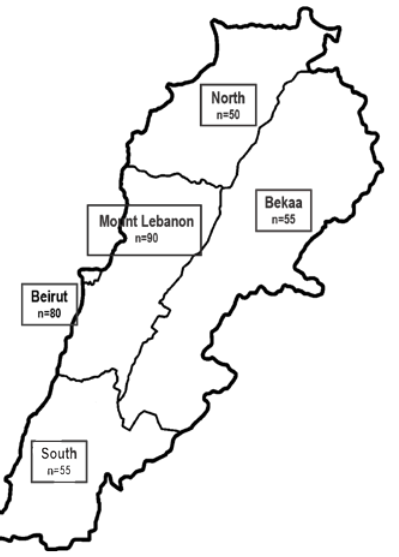
Figure 1. Distribution of sample according to district representation.